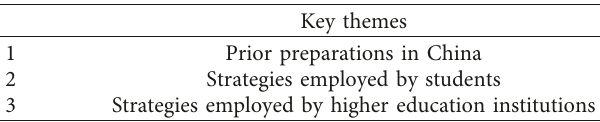
Table 3: Thematic analysis of interview transcripts.